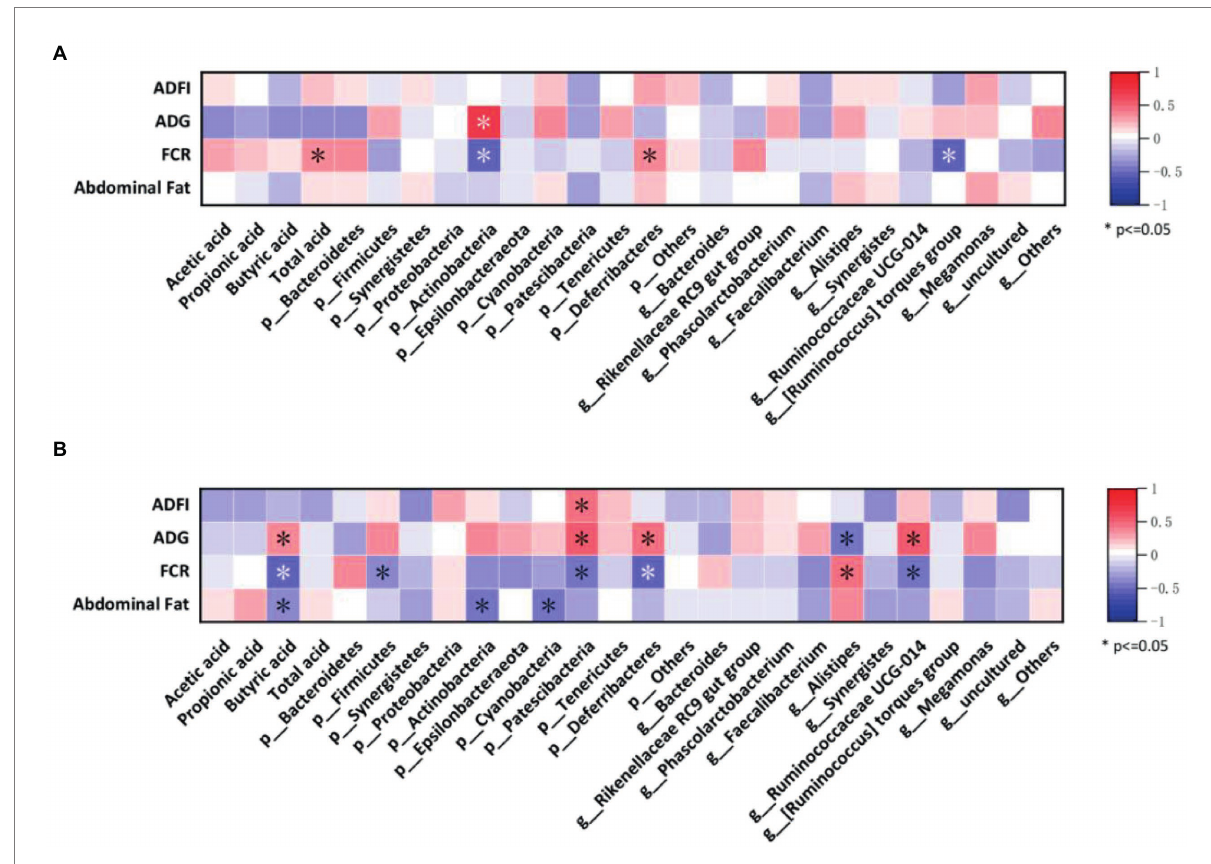
FIGURE 7 Correlation between the most abundant taxa of the cecal microbiota with growth performance and SCFAs of broilers. (A) Heatmap of samples from 35-day-old broilers; (B) Heatmap of samples from 56-day-old-broilers.